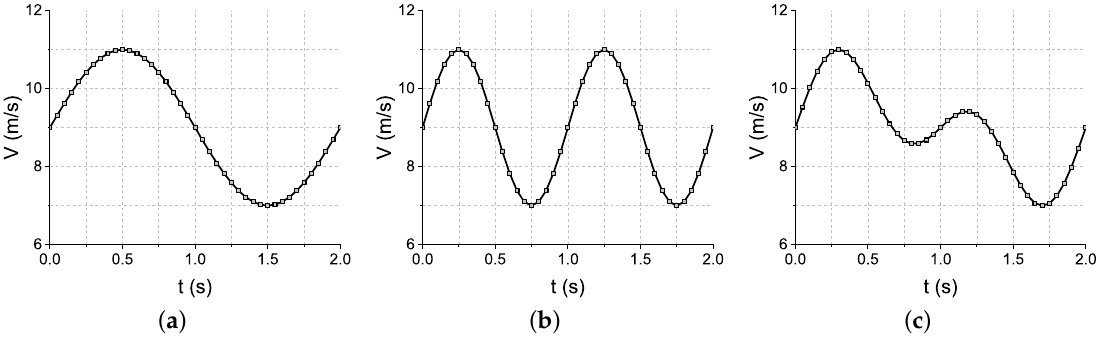
Figure 4. Variations of the inlet wind speed. ( a ) Case 4. ( b ) Case 5. ( c ) Case